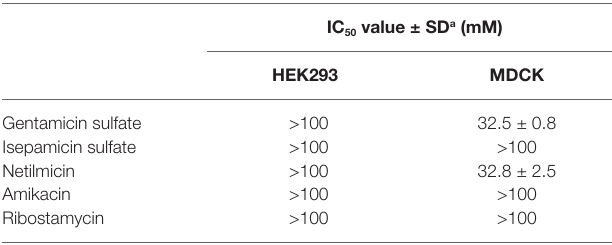
TABLE 2 | Cytotoxicity of aminoglycosides against two different kidney cell